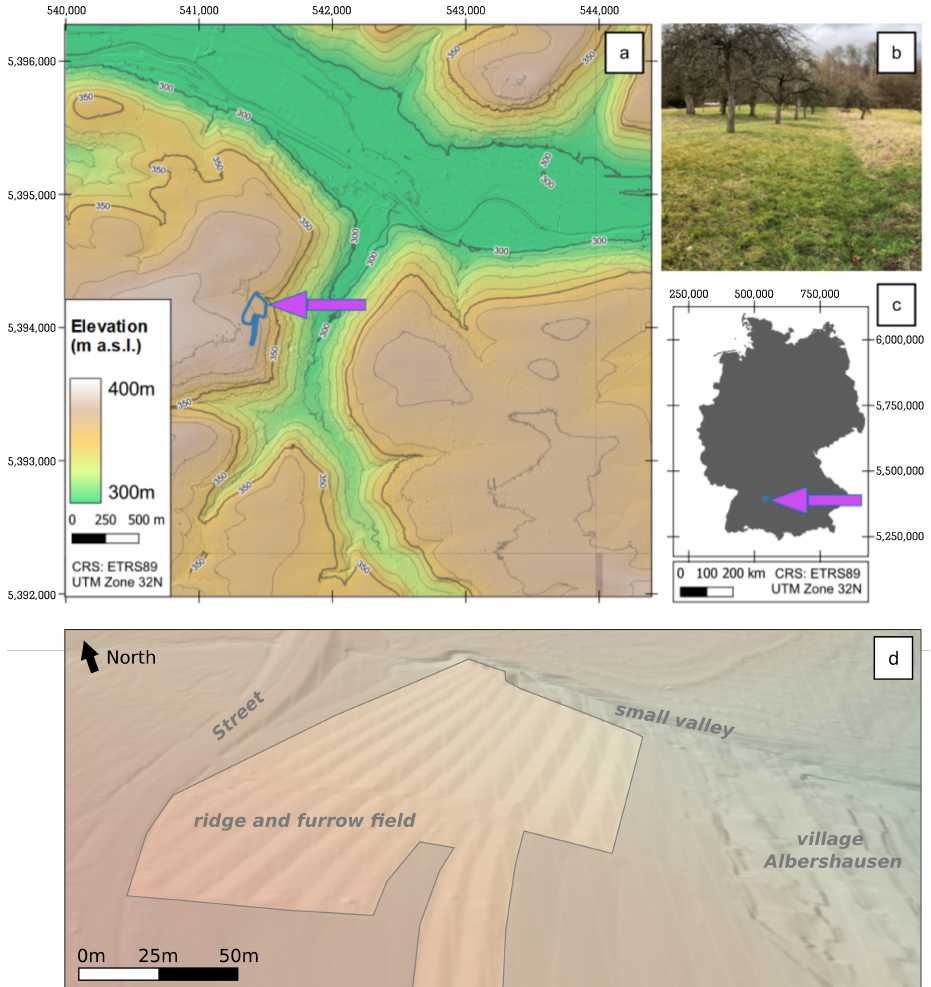
Figure 1. ( a ) Topographical map of the area surrounding the plot “Höfelbett” in Albershausen based on LiDAR DEM data (©www.lgl-bw.de (accessed on 24 January 2023)) [36]. The blue line frames the plot Höfelbett . ( b ) Picture of the plot with visible ridge- and furrow structures. ( c ) Location of the study area within Germany. ( d ) 3D view of the study area (elevation and hillshade) based on LiDAR DEM data (©www.lgl-bw.de (accessed on 24 January